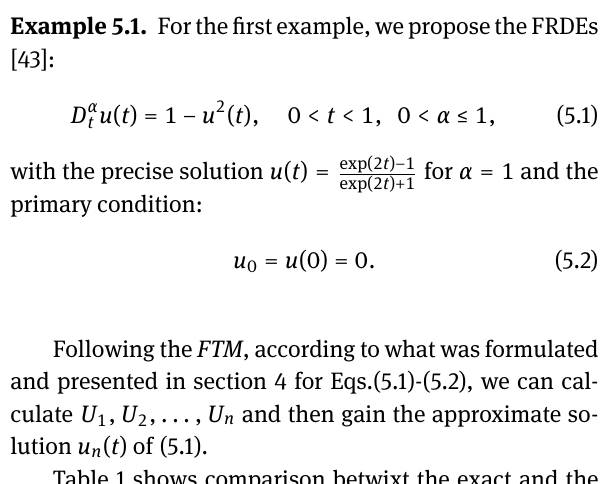
Algorithm 2. An approximation algorithm for FBDEs